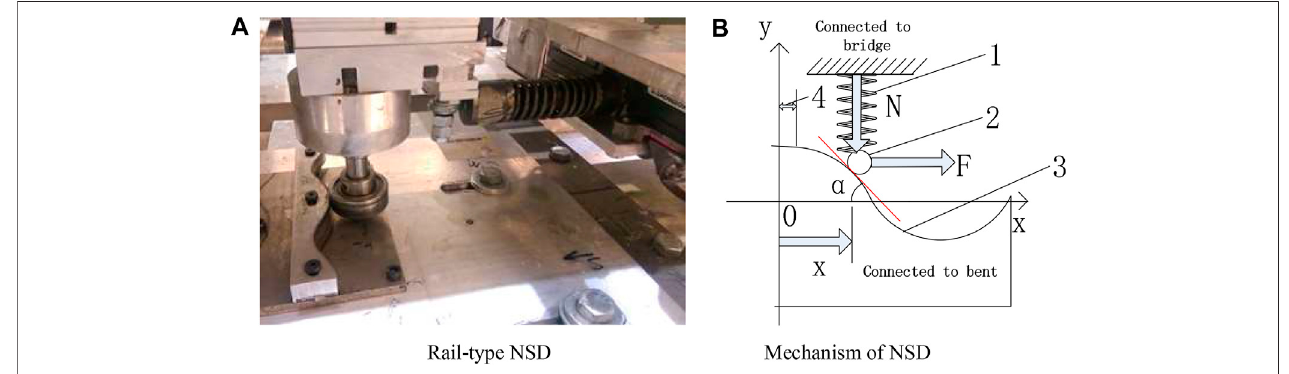
FIGURE 1 | Basic mechanism of the NSD. (A) Rail-type NSD and (B) Mechanism of